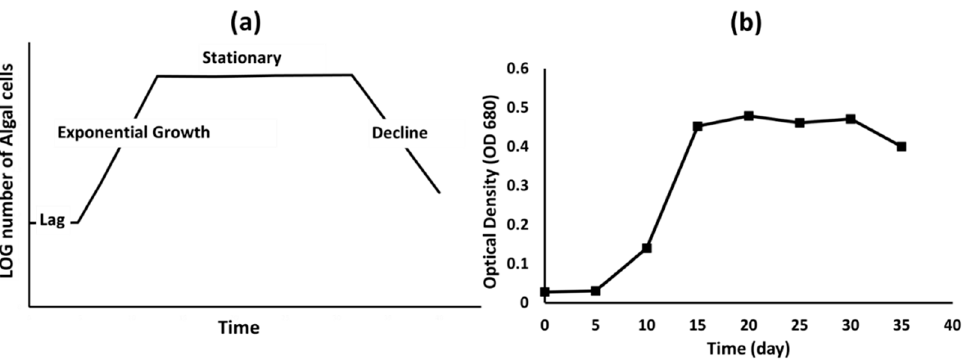
Figure 3. Algal growth curve. ( a ) Standard algal growth curve, ( b ) Chlorella vulgaris at 10% dilution of CM digestate.